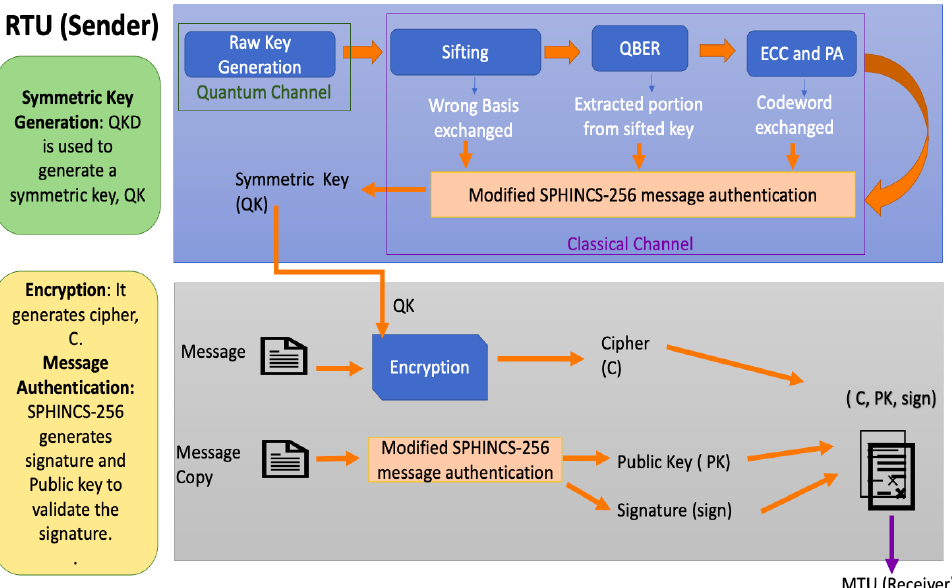
Figure 2. The structure of our proposed scheme. It includes symmetric key generation, Encryption and message